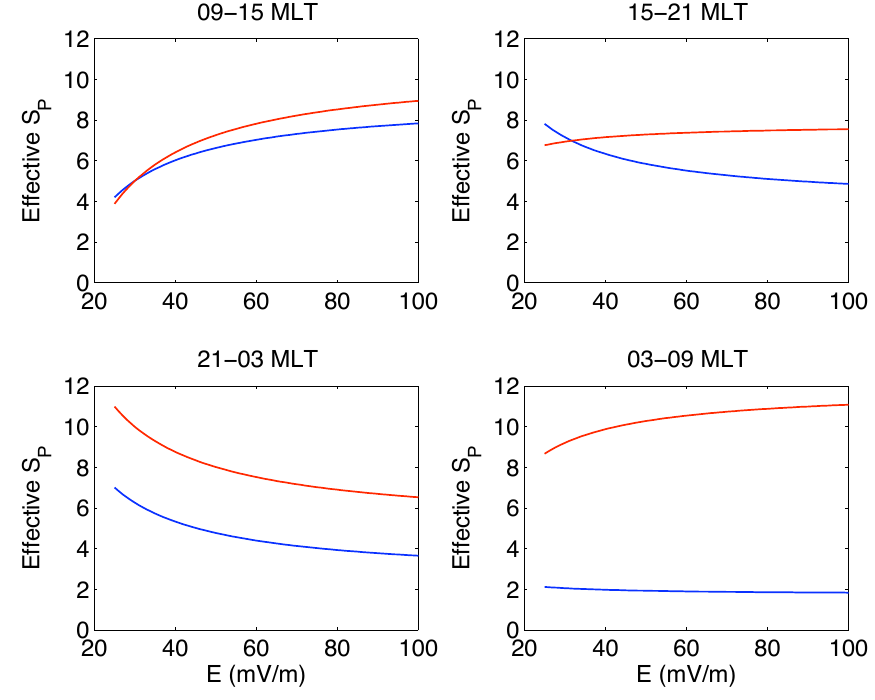
Fig. 18. Effective conductance as a function of electric field magnitude in the four MLT sectors. The blue curve is for K p < 3 and the red curve for K p ≥